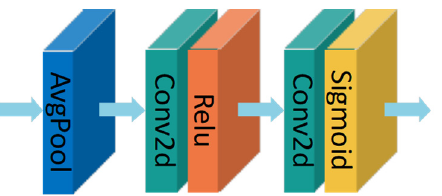
Figure 5. Structural diagram of the channel attention module.